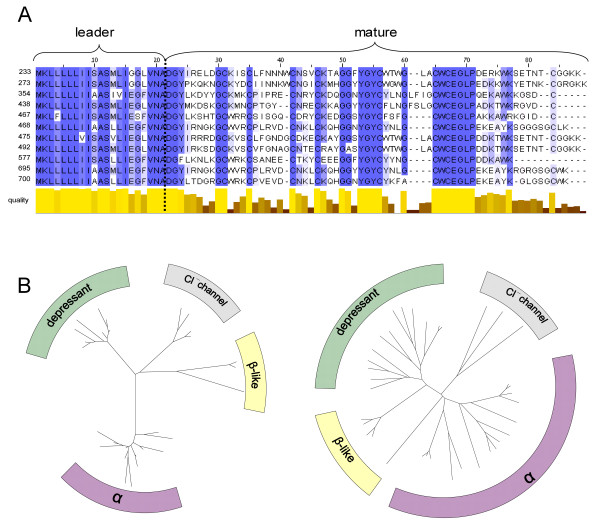
Conservation levels within the coding region. (A) Putative leader and mature domains of the depressant toxin family, as displayed by Jalview. Amino acid residues are shaded according to residue identity in a color scale from blue (high) to white (low). Position-specific similarities are indicated by the quality parameter (taking into account amino acid characteristics). The degree of similarity is indicated by bar height and color, ranging from light yellow (high) to dark brown (low). (B) Unrooted trees for the leader and the mature toxin regions of several toxin families. The toxin families' identity is indicated over each cluster. While in the leader domain, all the gene family segregate into clearly defined branches, in the mature domain, the transcripts start to diverge from a point much closer to the origin, in a star-like shape.